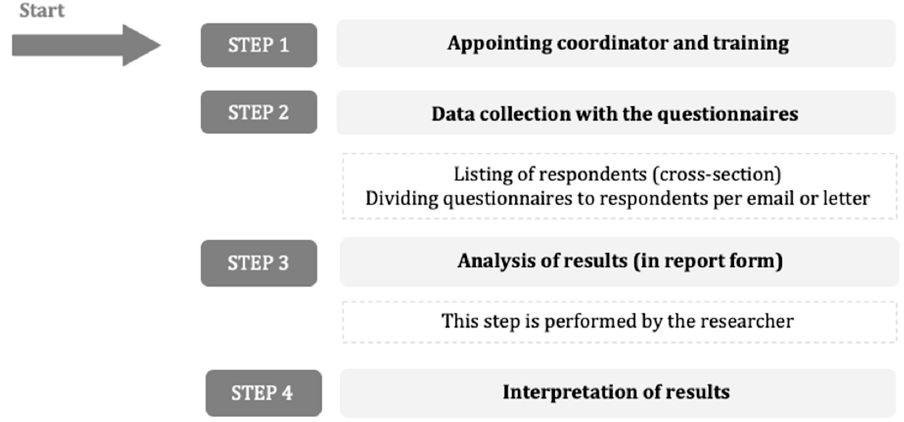
Figure 2. Measurement